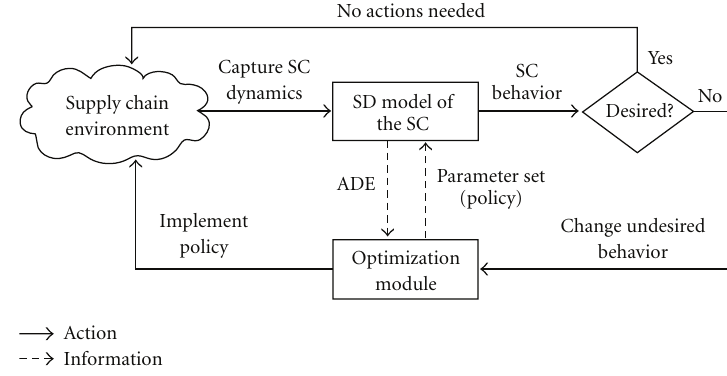
Figure 1: General procedure of the SADE methodology.